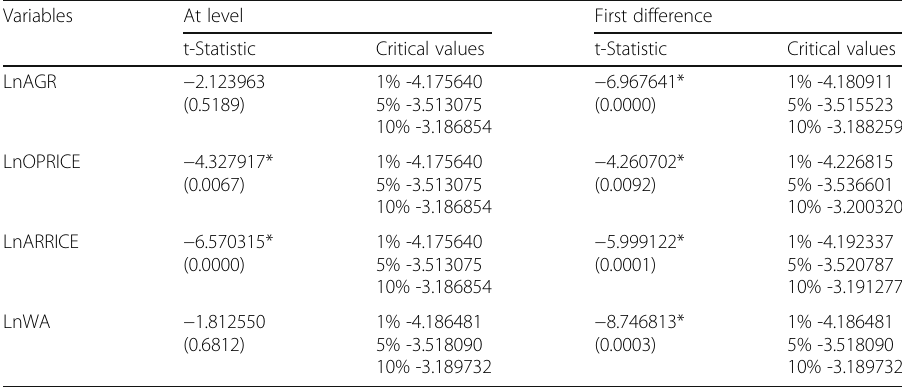
1% -4.175640 5% -3.513075 10% -3.186854 1% -4.175640 5% -3.513075 10% -3.186854 1% -4.175640 5% -3.513075 10% -3.186854 1% -4.186481 5% -3.518090 10% -3.189732